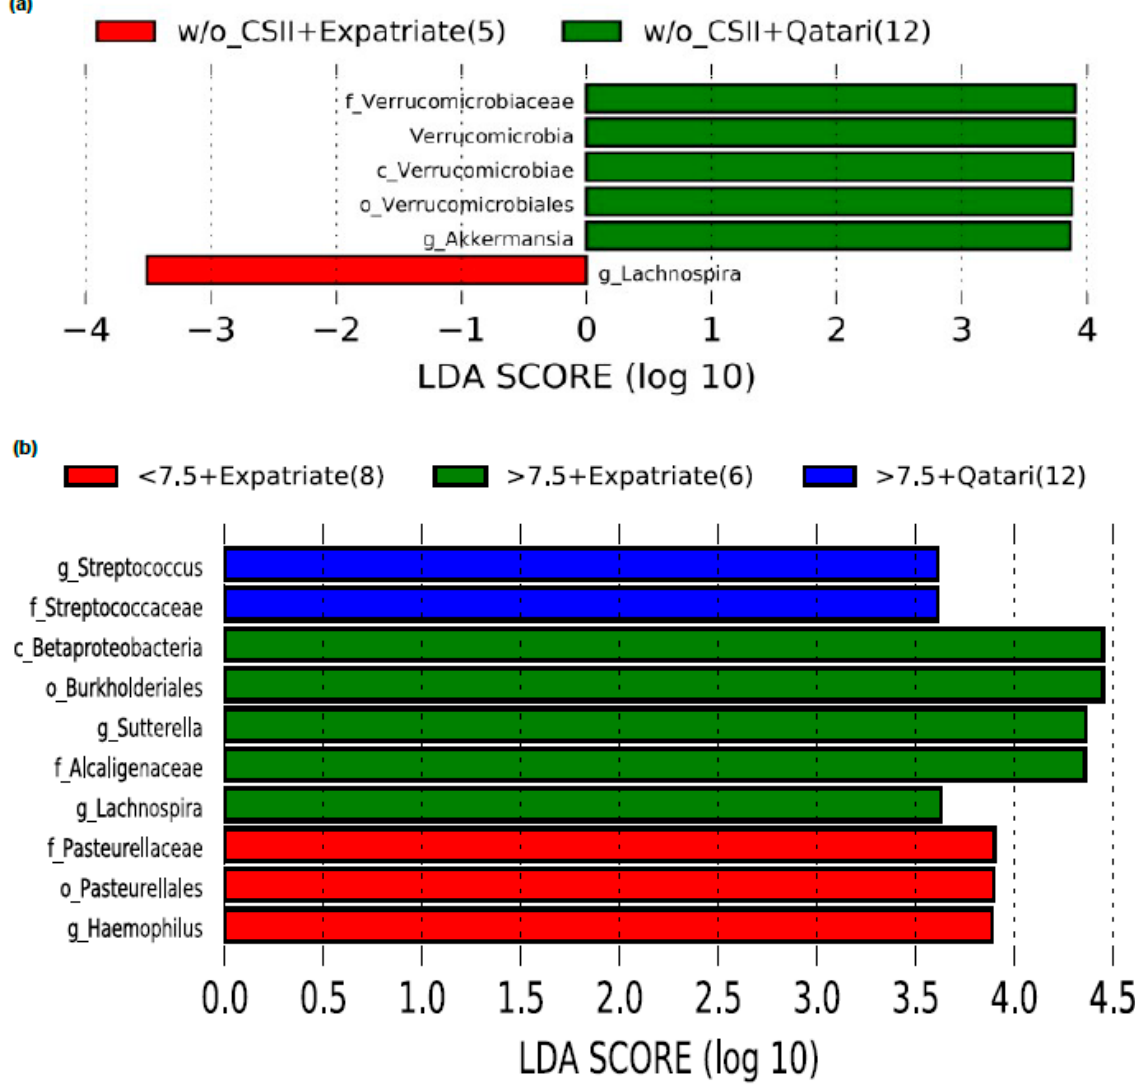
Figure 4. Impact of CSII therapy and nationality on genus Akkermansia in poorly controlled T1DM subjects. ( a ) Akkermansia was enriched only in the Qataris T1DM subjects without CSII therapy and ( b ) Akkermansia disappeared analyzing HbA1c levels according to nationality. LDA cutoff value > 2.0; Note: g_UC, genus_unclassified; w/_CSII, with CSII therapy; w/o_CSII, without CSII therapy.